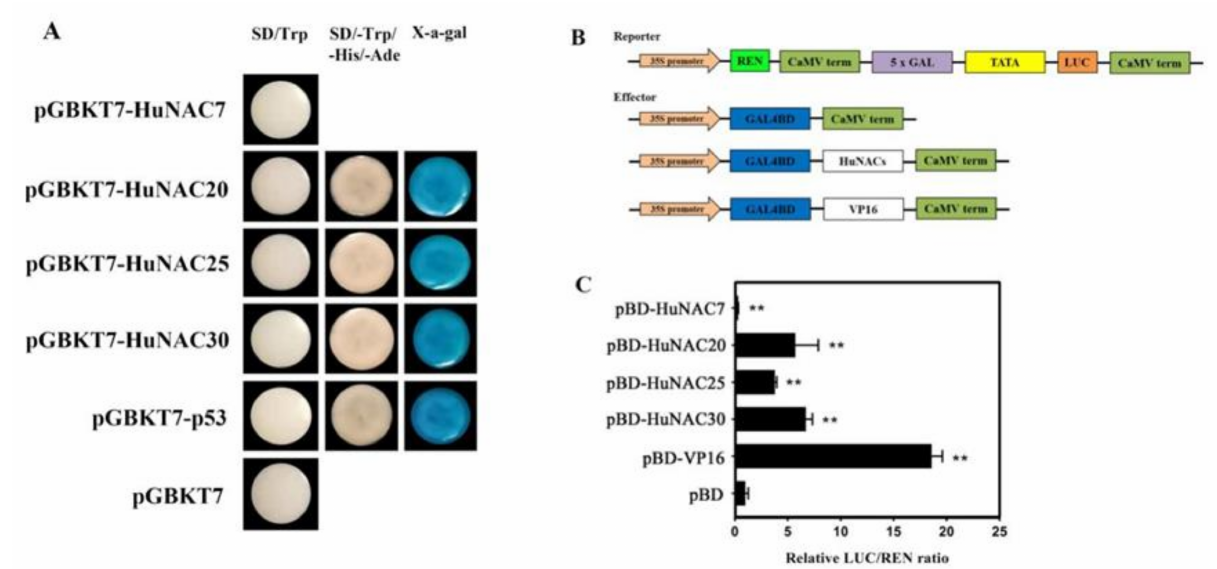
Figure 7. Transcriptional activation analyses of HuNACs. ( A ) transcriptional activation of HuNAC in yeast cells. pGBKT7 and pGBKT7-53 + pGADT7-T were used as negative and positive controls, respectively. Transcription activation was monitored according to growth status of yeast cells and an α -Gal assay; ( B ) diagrams of the reporter and effector vectors; ( C ) transcriptional activation of HuNACs in N. benthamiana leaves. The trans-activation ability of HuNACs is indicated by the ratio of LUC to REN. The LUC/REN ratio of the empty pBD vector (negative control) was used as a calibrator (set as 1). pBD-VP16 was used as a positive control. The asterisk indicates a significant difference at the 1% level compared to the